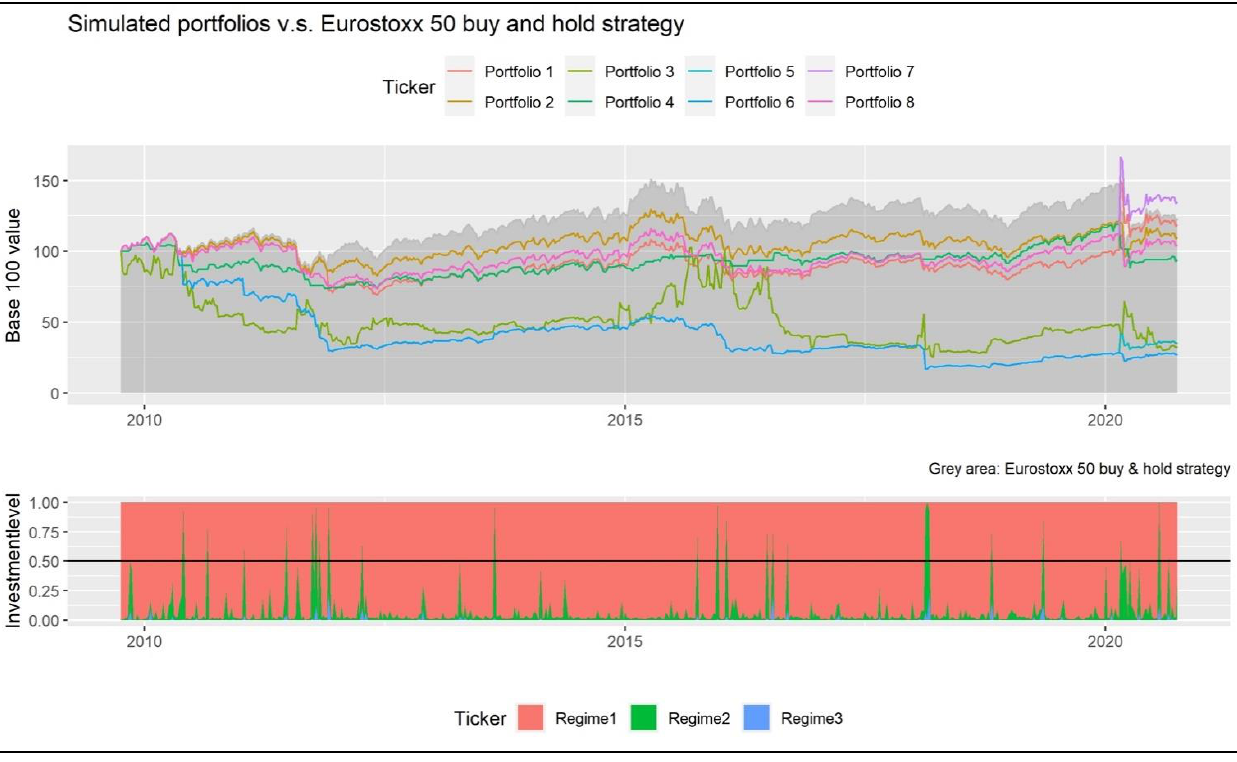
Figure 2. Weekly historical performance of the eight simulated portfolios of Table 2 with a fully invested weighting method ( ω i = 100% if ξ s = i , T + 1 > 50%). ( upper chart ) It presents the historical 9 July 2009 Base 100 value of the eight simulated portfolios (lines) against a buy-and-hold ESTOXX50 strategy (grey area) ( lower chart ) The historical three-regime MS-GARCH regime-specific forecasted smoothed probabilities ( ξ s = i , T + 1, t ). Methodological note: The eight simulated portfolios do not include the impact of stock trading